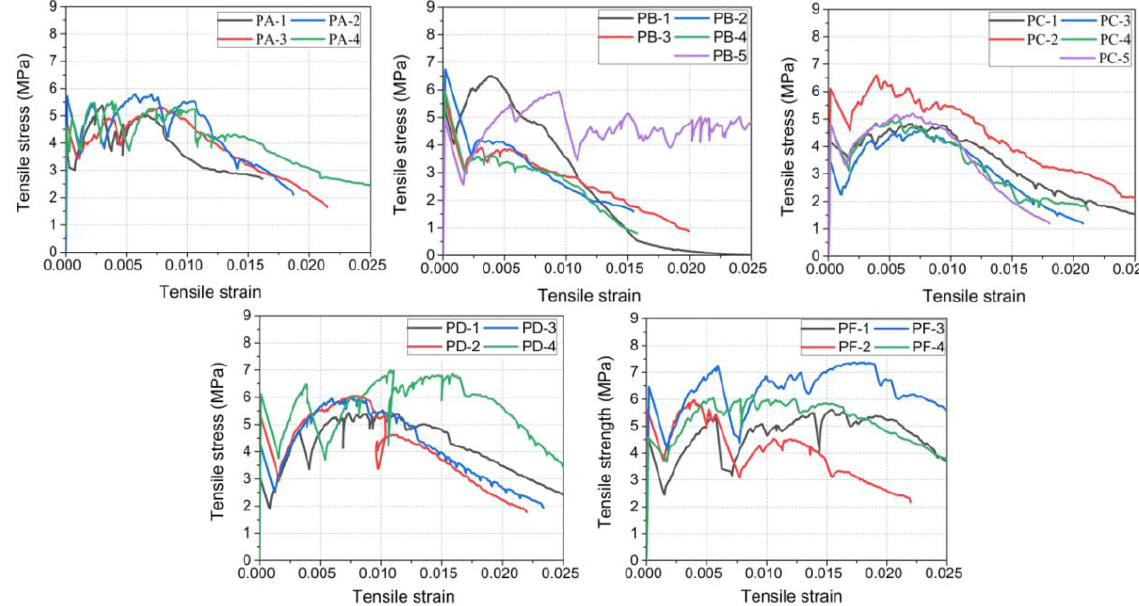
Figure 9 . Relationship between tensile stress and strain of UHPC with PE fiber. Figure 9. Relationship between tensile stress and strain of UHPC with PE fiber.